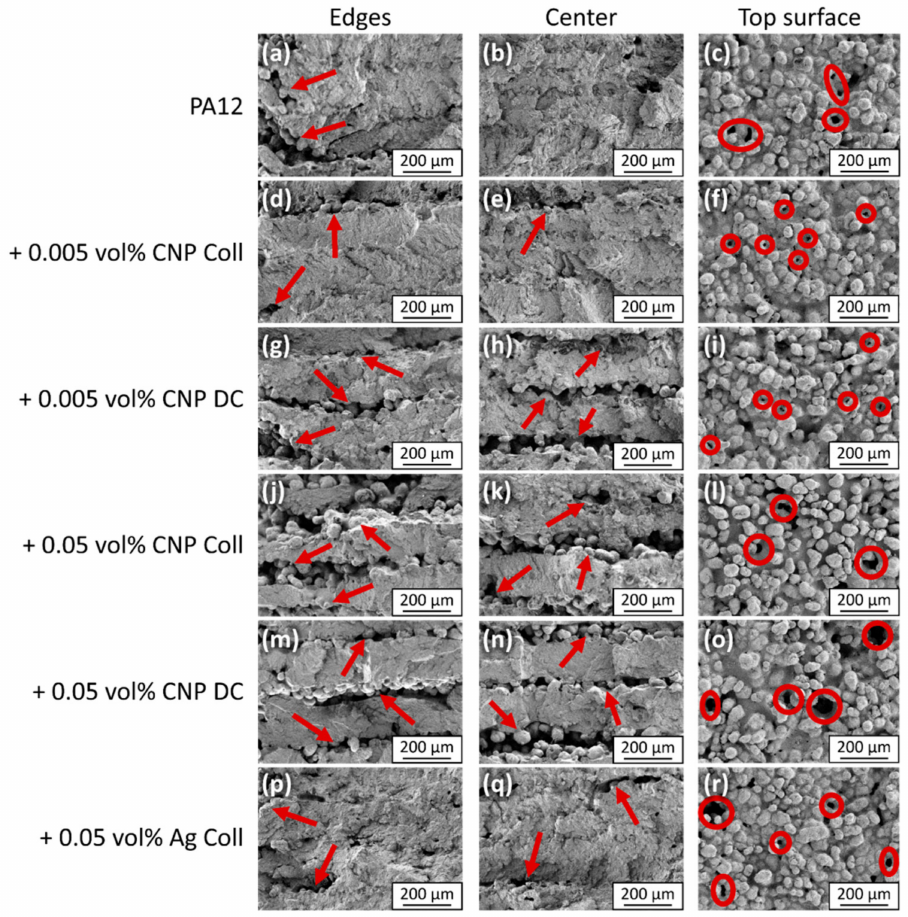
Figure 7. Collection of scanning electron microscopy images of the fractured surfaces of the tensile bars and of the top surface of the specimens. The left column ( a , d , g , j , m , p ) depicts the edges, and the middle column ( b , e , h , k , n , q ) shows the center of the fractured surface. The condition of the specimens’ top surface can be seen in the right column ( c , f , i , l , o , r ). The quantity of nanoparticles increases from top to bottom. Exemplarily, the red arrows mark unmelted polymer particles, while the red circles highlight voids.